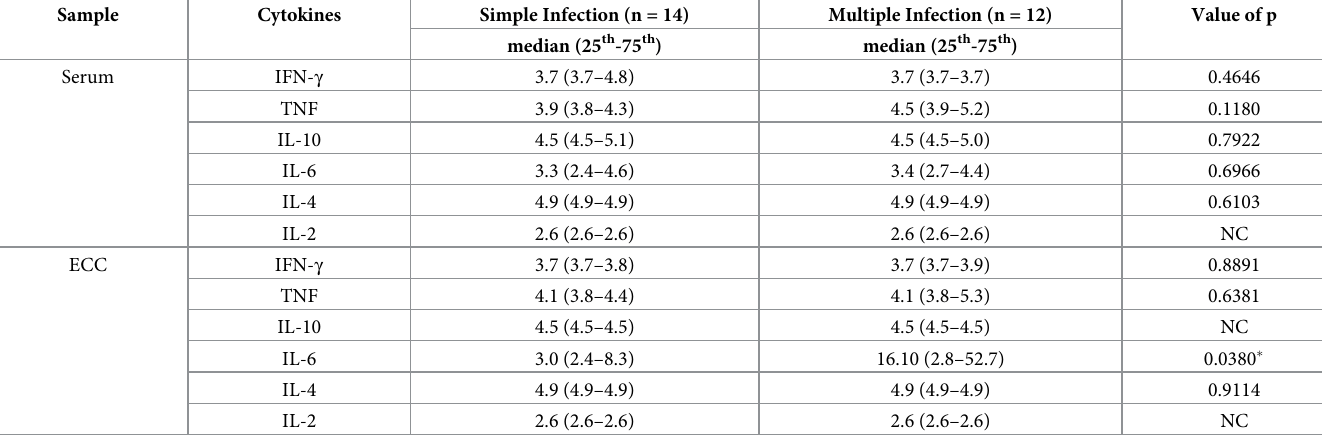
Table 4. Cytokine levels in the Exfoliated Cervical Cell (ECC) and serum of patients with single and multiple infections.